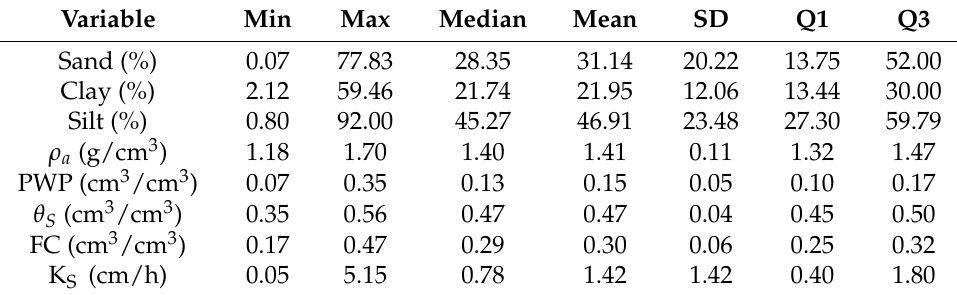
Table 1. Statistical properties of data measured in the